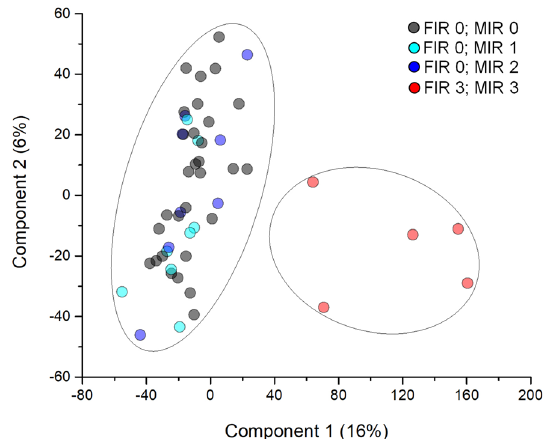
Figure 1. Multidimensional scaling (MDS) of bioptic amnion proteome profiles. Scatter plot of MDS analysis of FIR 3-MIR 3 (red circles), FIR 0-MIR 2 (blue circles), FIR 0-MIR 1 (cyan circles) and FIR 0-MIR 0 (black circles) samples. Ellipsis indicates 95% confidence interval. Plot shows clustering of two distinct groups (FIR 3 and FIR 0